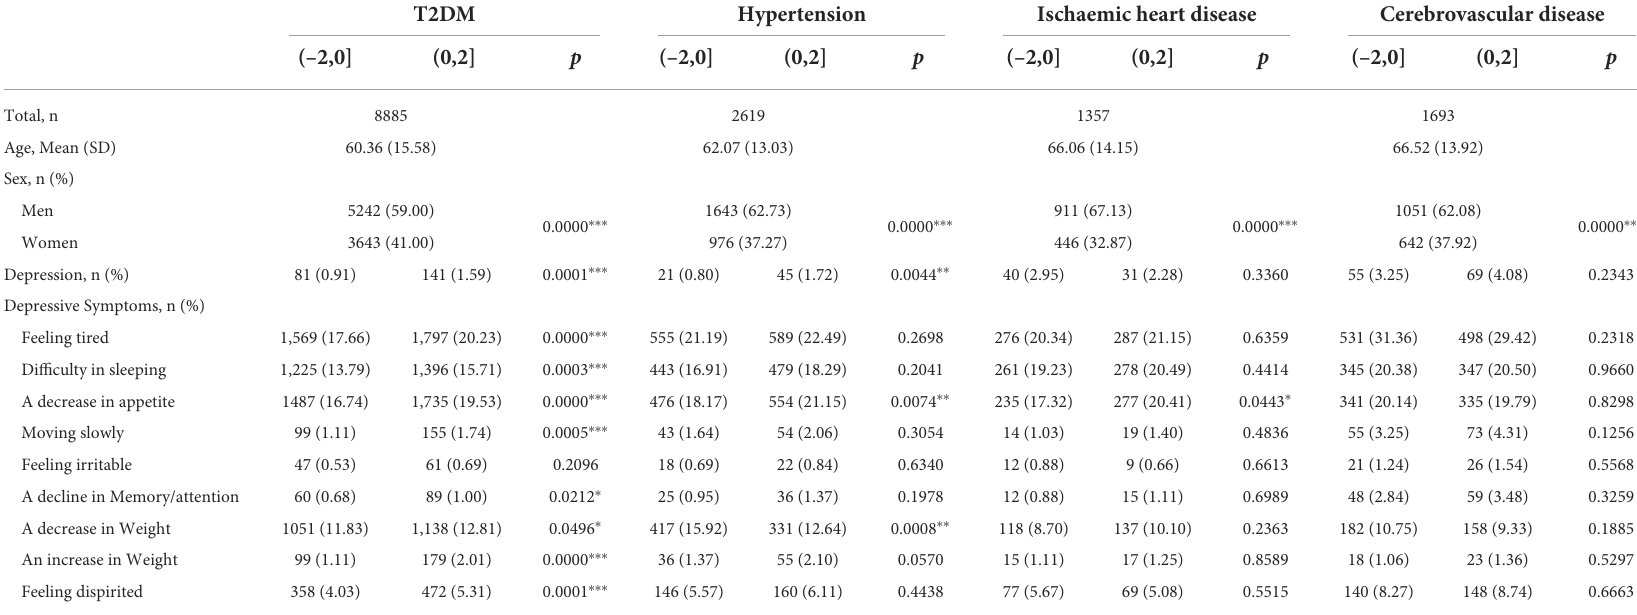
TABLE 1 Descriptive statistics for each diseases in these windows of